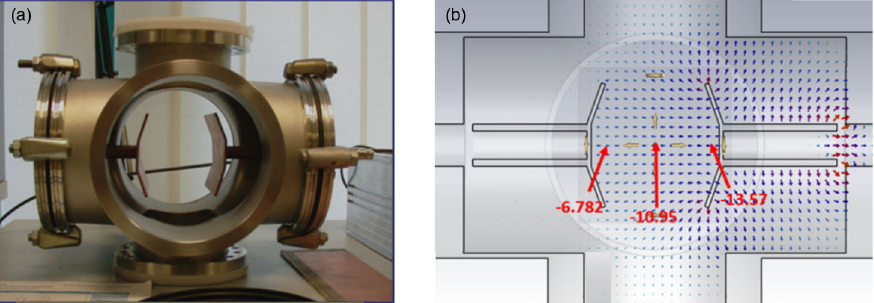
FIG. 4. Fast chopper deflection plates. (a) Photo of vacuum tank showing the deflection plates: leftmost plate is grounded, rightmost plate is connected via feedthrough to HV. (b) Simulation of the electric field between deflection plates. Numbers in red (E indicate a variation of factor of 2 due to field asymmetry.